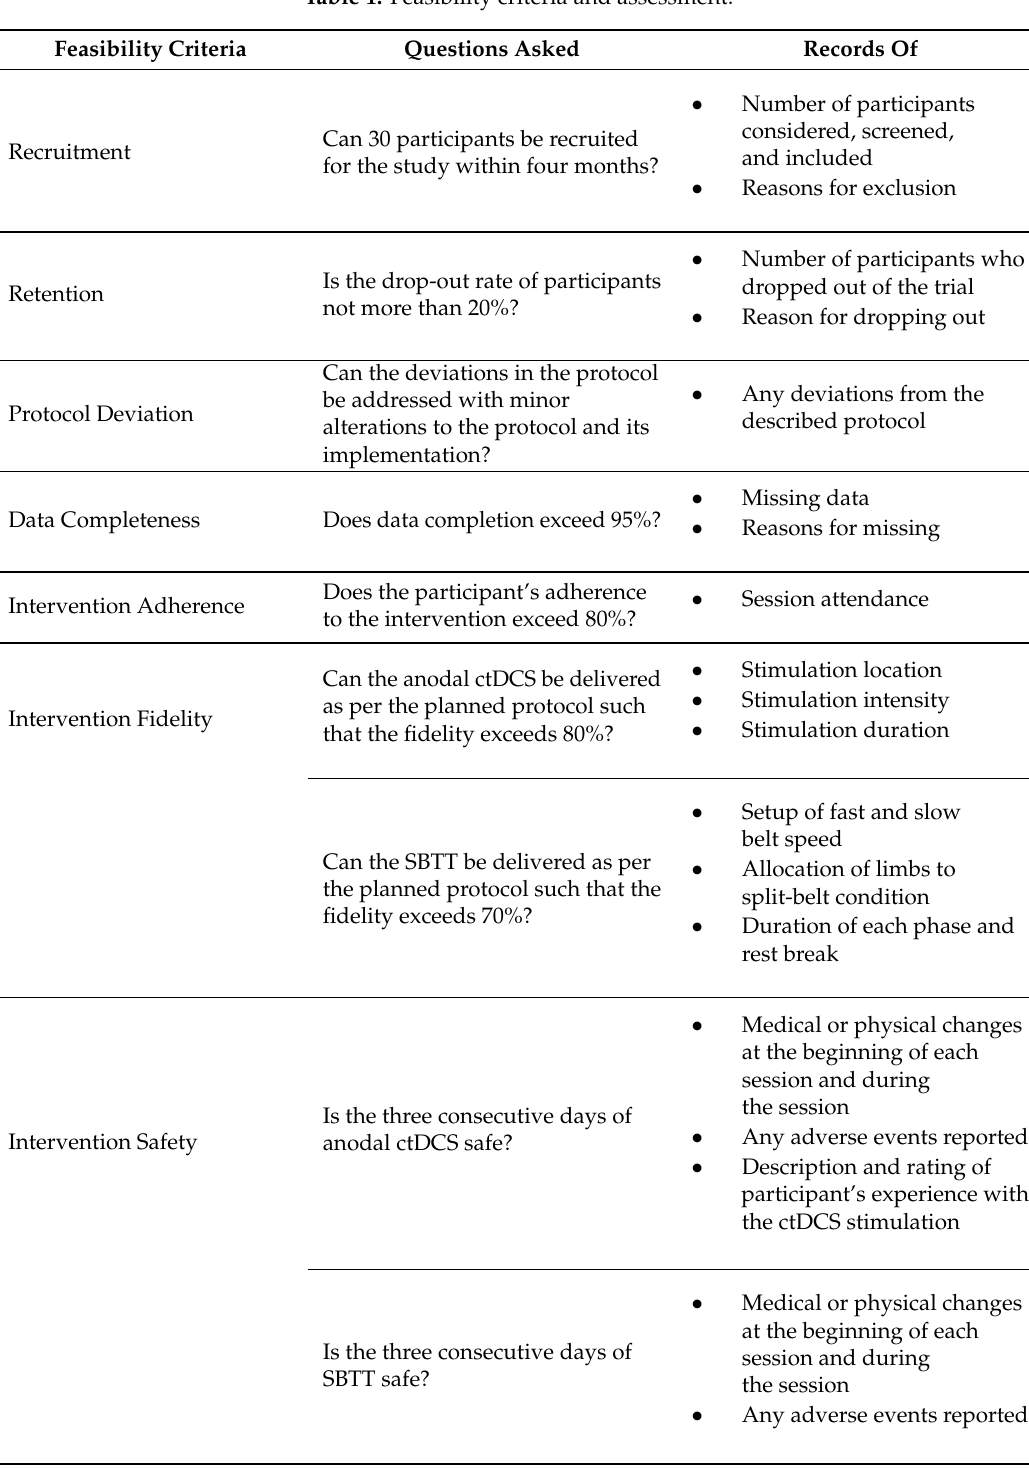
Table 1. Feasibility criteria and